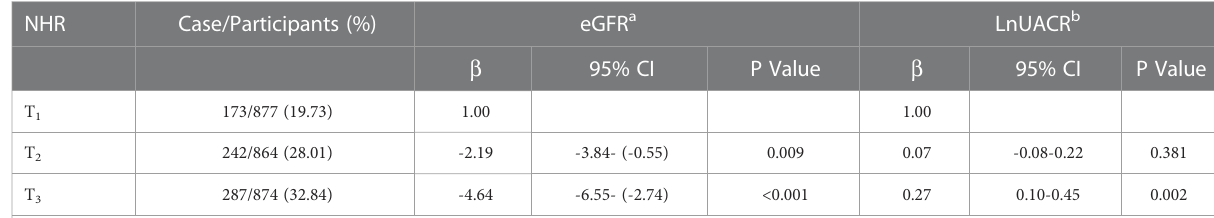
TABLE 3 Associations between NHR and eGFR/LnUACR level in patients with